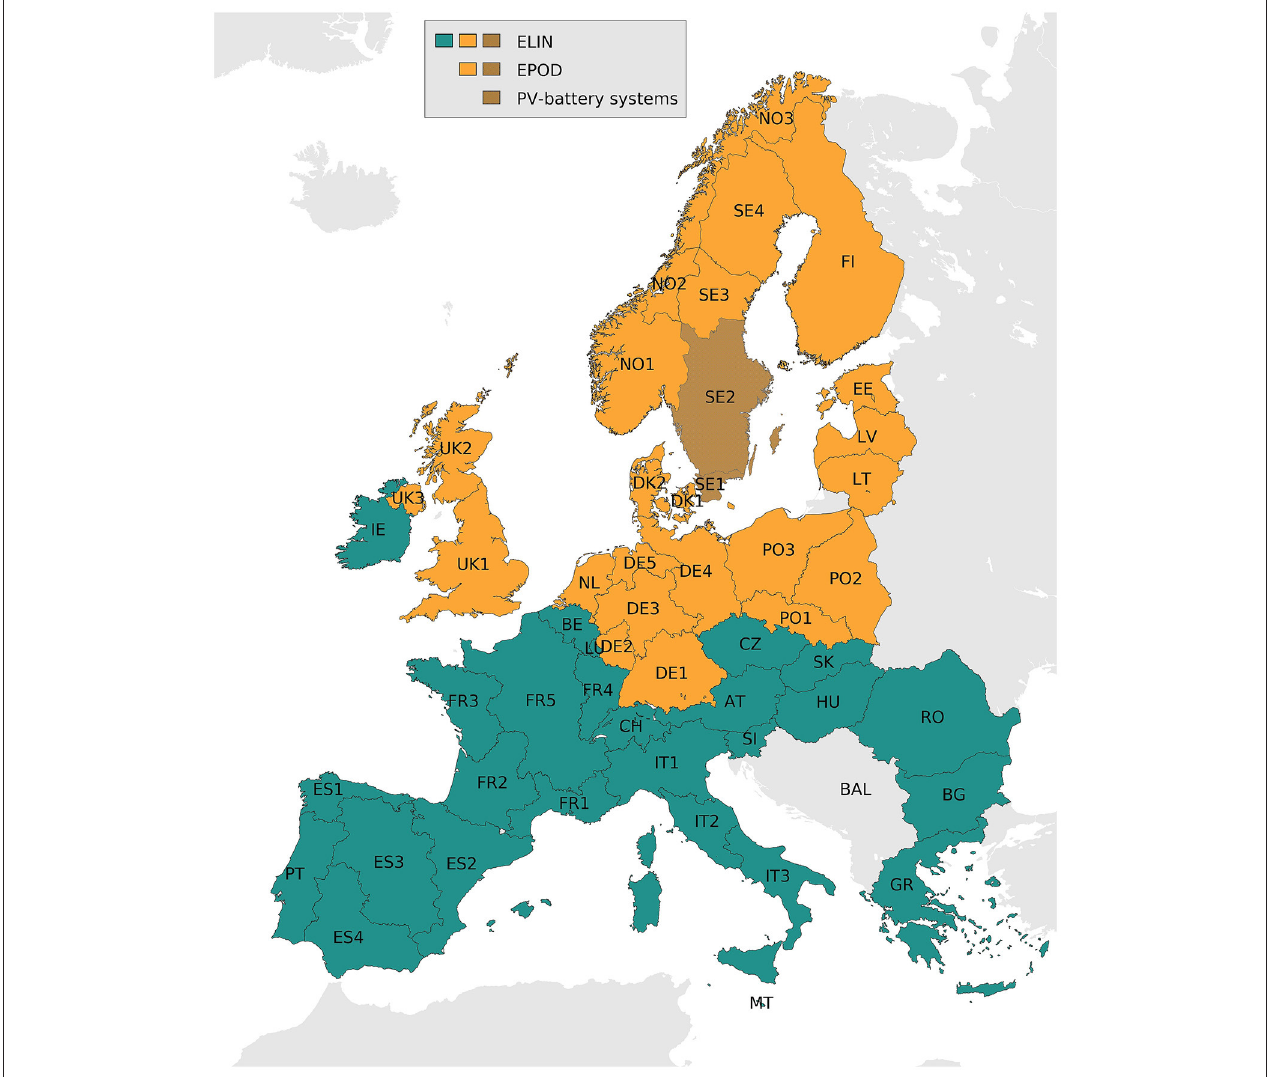
FIGURE 2 | Regions considered in the ELIN (green, orange, and orange-patterned) and EPOD (orange and orange-patterned) models. Residential PV-battery systems (orange-patterned) are included in the southern Swedish regions (SE1 and SE2) in the modeling package [Figure adapted from Goop et al.